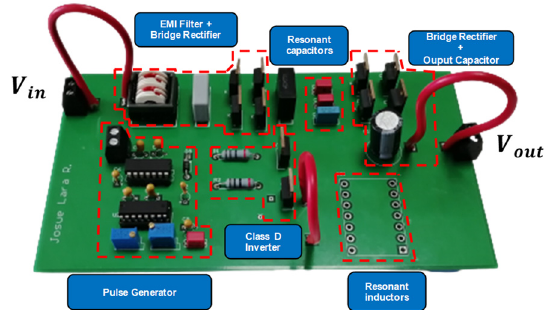
Figure 18. Experimental prototype of the circuit.